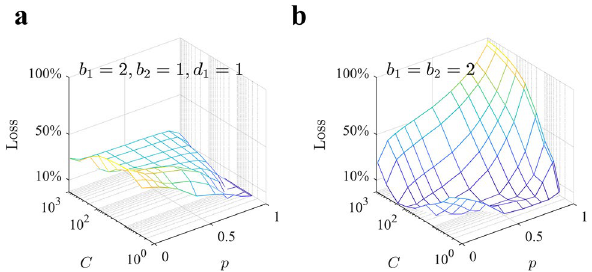
Figure 9. Loss incurred in playing the tree always with a specific heuristics instead of the optimal two- b policy. ( a ) Relatively restrained loss occurs using as a heuristics the deep allocation policy ( b 1 , b 2 , d 1 ) = ( 2, 1, 1 ) . ( b ) Optimal two- b policies clearly outperform the generally optimal single- b policy with parameters b = b 1 = b 2 = 2 . Loss is defined as 100 ( V opt − V )/ V opt , where V opt is the optimal value from Fig. 8a and V is the value corresponding to the specific heuristics. Results are obtained with the theoretical predictions by Eqs. (12,19,20) and Eqs. (12,27,28) (Sect. “Value of exhaustive or selective search in a large tree with rational p ” of the Methods).